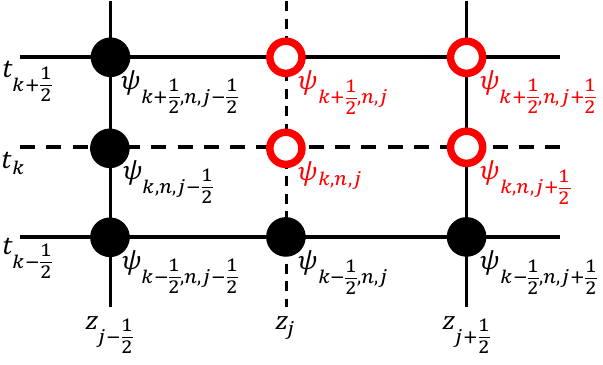
> 𝟎 ) sweep operations. Given the black 𝒏